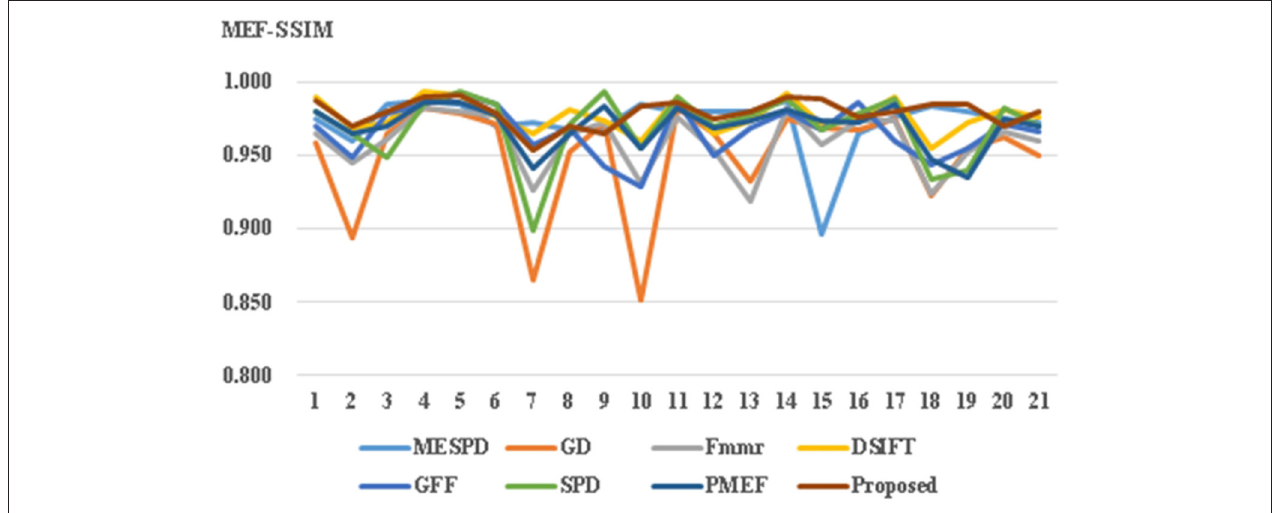
FIGURE 7 | Comparison of MEF-SSIM indexes of seven fusion